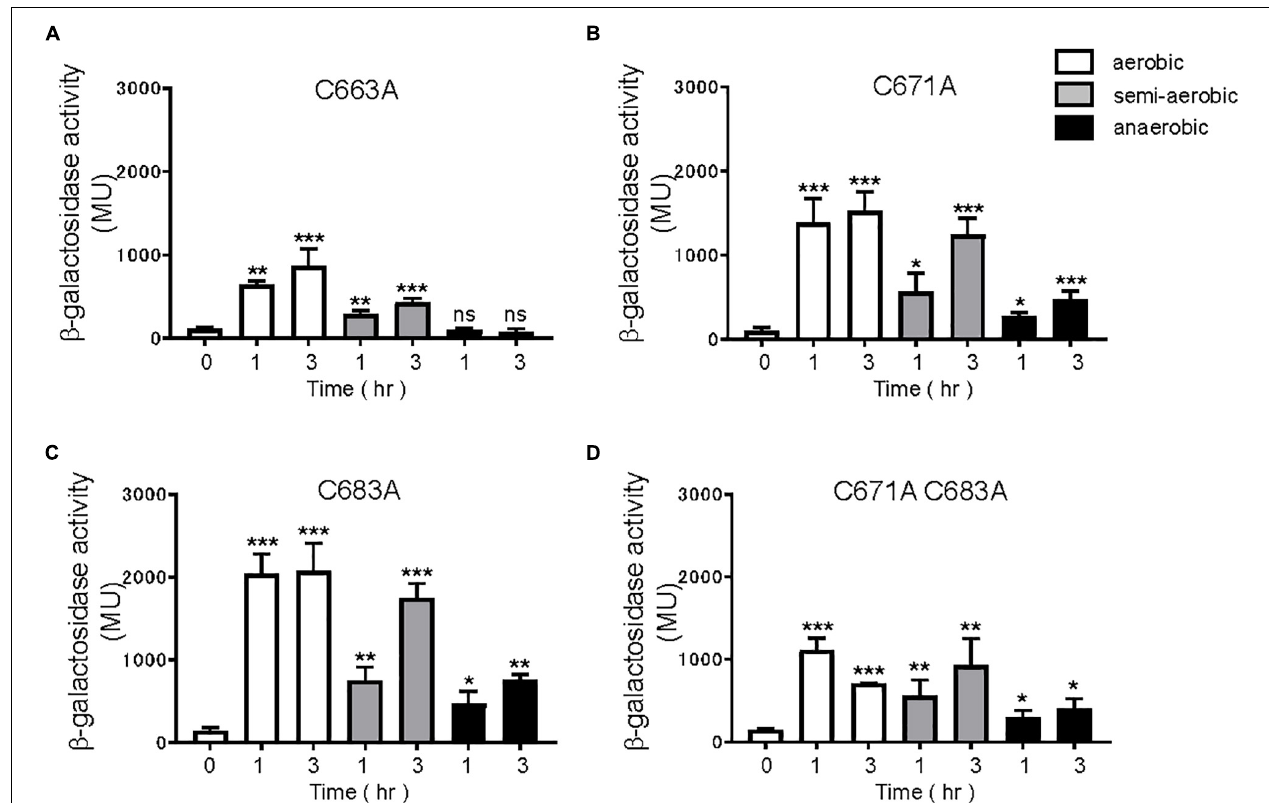
FIGURE 5 | Response to aeration in EvgS-PAS mutants. (A) MG1655 evgS ydeP-lacZ/ pBADevgS C663A, (B) MG1655 evgS ydeP-lacZ/ pBADevgS C671A, (C) MG1655 evgS ydeP-lacZ/ pBADevgS C683A, (D) MG1655 evgS ydeP-lacZ/ pBADevgS C671A C683A. Activity of the ydeP-lacZ reporter in different culturing conditions (upper panels). Cells were grown in EvgS-activation medium with 0.02% arabinose under aerobic (white bars), semi-aerobic (gray bars), or anaerobic condition (black bars) at 37 ◦ C. Optical density at 600 nm of the cell cultures subjected to reporter assays is shown in Supplementary Figure 6 . Data represent the average of three biologically independent replicates. Error bars indicate the standard deviation, and statistical analyses of each redox condition group were performed as described in Figure 1 . ns, not significant; *0.01 ≤ p < 0.05; **0.001 ≤ p < 0.01; *** p <